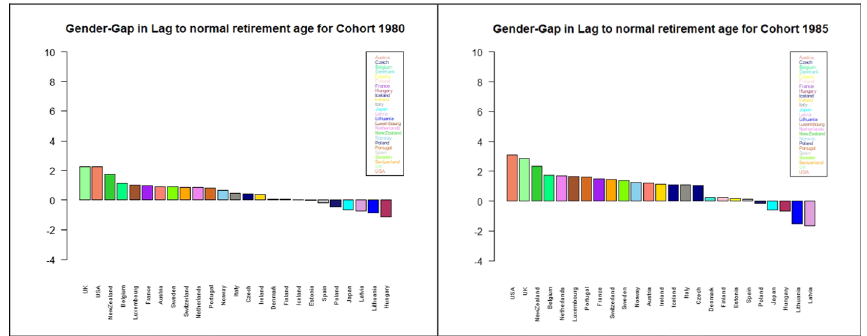
Fig. 2 Gender gap in lag to NRA under the proposed indexation mechanism for pensions for selected cohorts (countries are sorted by decreasing order in g)